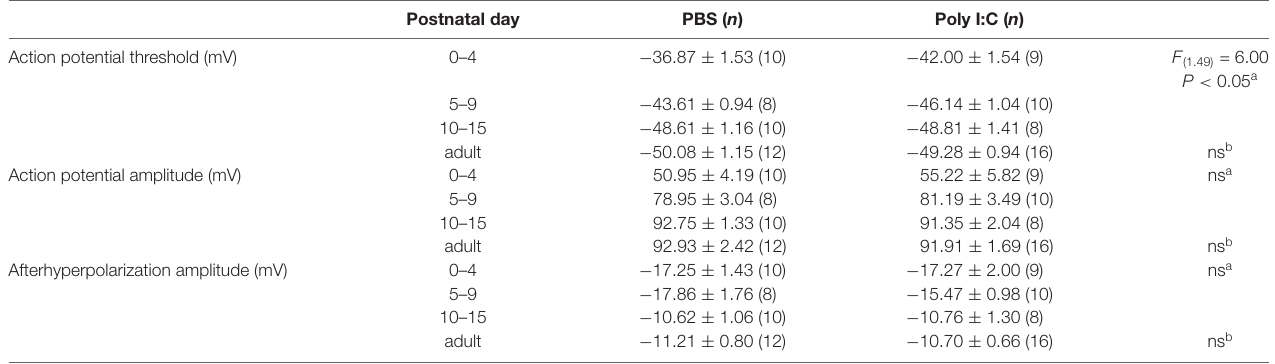
TABLE 1 | Membrane properties of pyramidal cells from offspring of PBS-treated and poly I:C-treated dams.